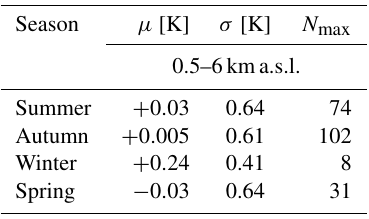
Table 6. Seasonal mean bias µ , standard deviation σ and maximum availability N max at